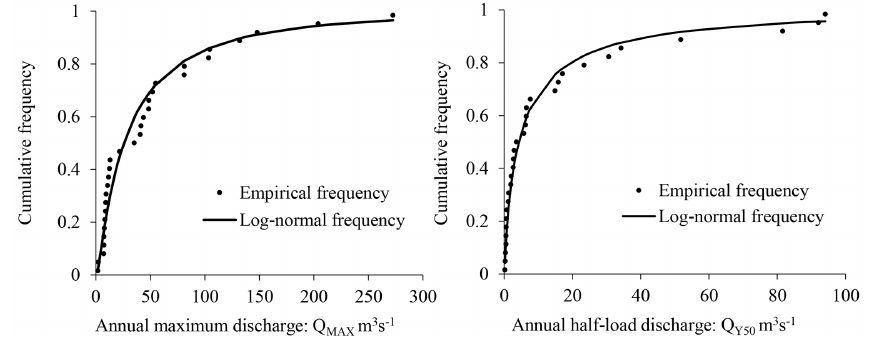
Figure 8. Adjustment to the log-normal distribution of maximum annual discharge, Q MAX , and median annual discharge in terms of sediment yield, Q Y 50